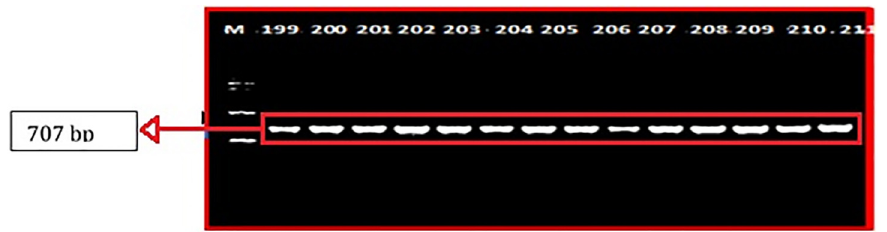
Figure 3. DNA amplified using Fish-F1 and Fish-R1 primers; M= Marker 100 bp (Vivantis, Malaysia); 199, 200, 201, 202, 203, 204, 205, 206, 207, 208, 209 and 210= Rokan River; 211= Kampar River.